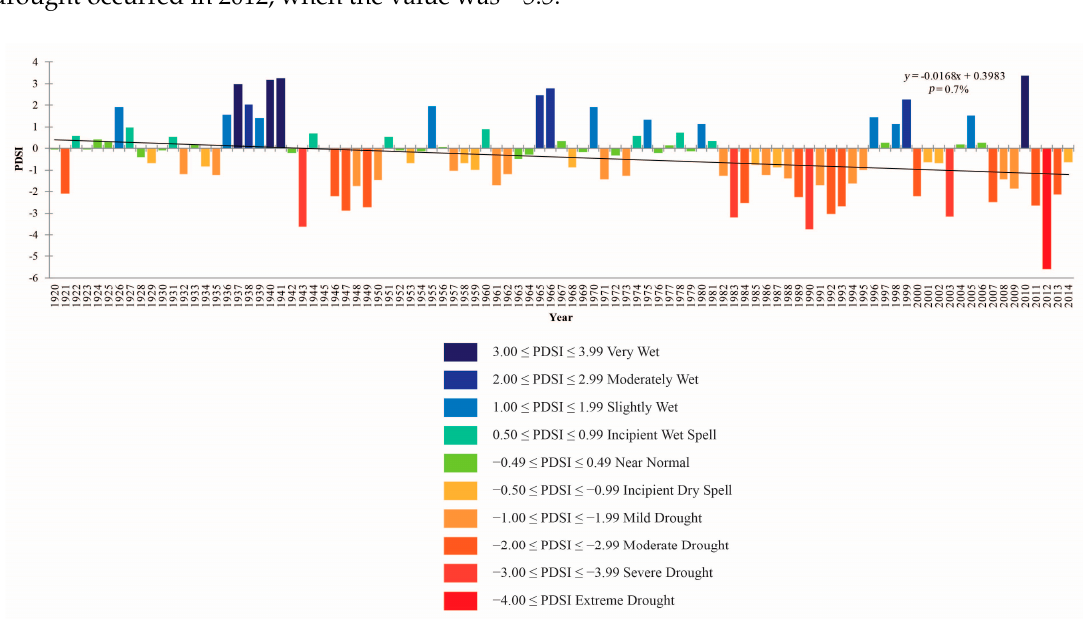
Figure 10. The distribution and trend of the PDSI for Hungary and Vojvodina presented jointly during the period 1920–2014. The PDSI trend is presented with a solid, black line and trend equation, and p is the probability.